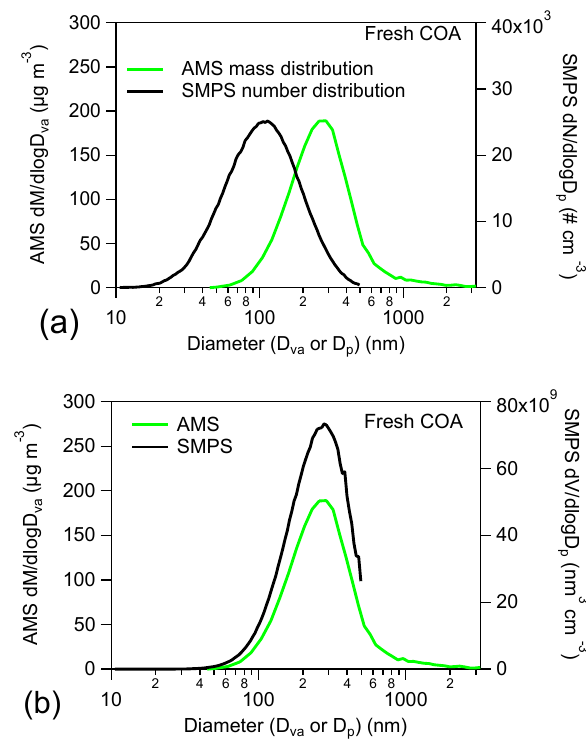
Figure 2. (a) SMPS number and AMS mass distributions versus D p and D va correspondingly for fresh COA and (b) SMPS volume and AMS mass distributions versus D va and D p